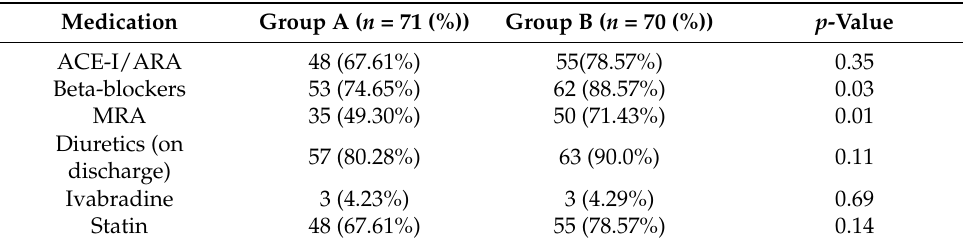
Table 2. Medical treatment in the study